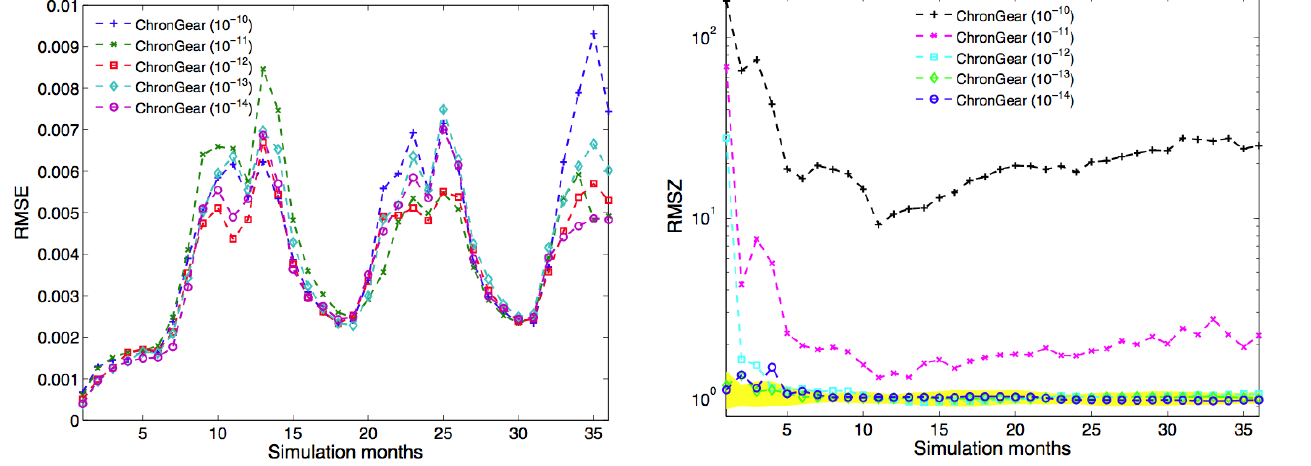
Figure 1. Monthly root mean square error (RMSE) of temperature for experiments with different barotropic solver convergence toler- ances. Note that this is a subset of Fig. 12 in Hu et al. (2015).